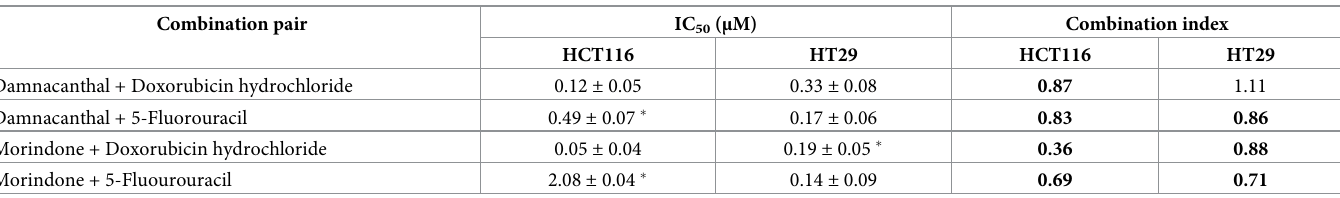
Table 4. IC 50 and combination index (CI) values.